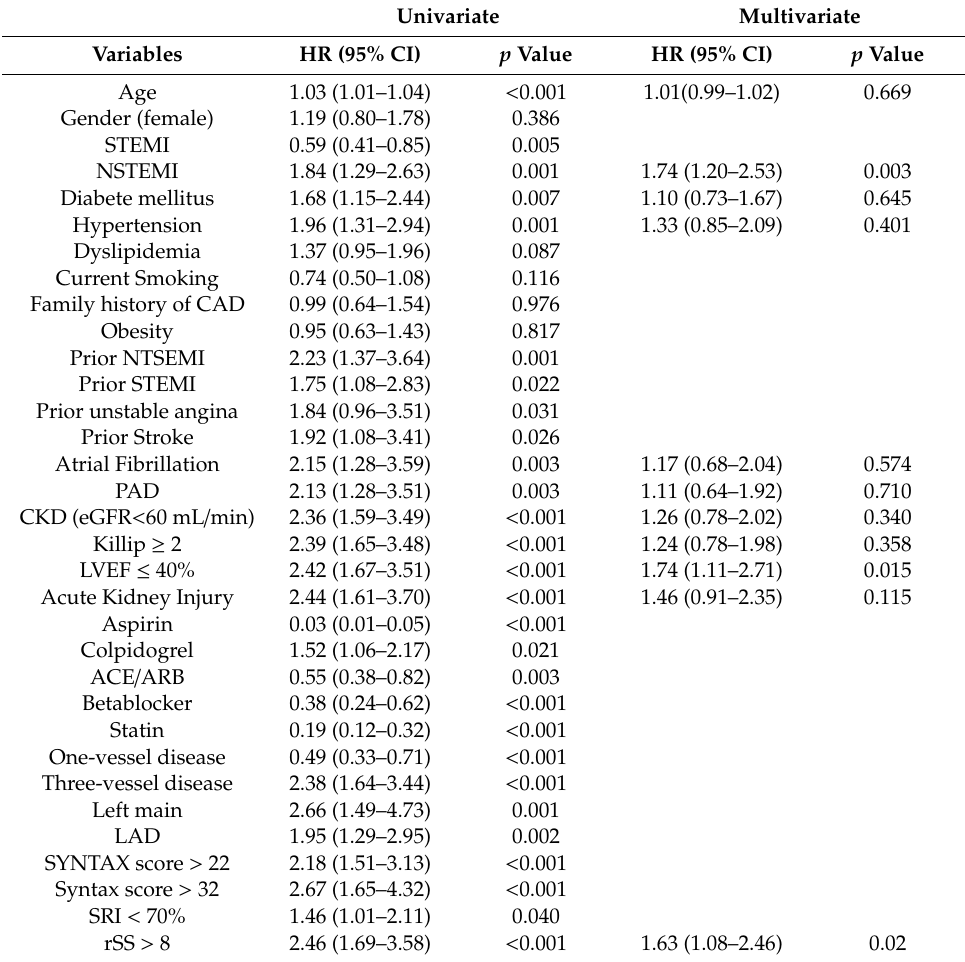
Table 8. Univariate and multivariate analysis of risk factors associated with MACE. Univariate